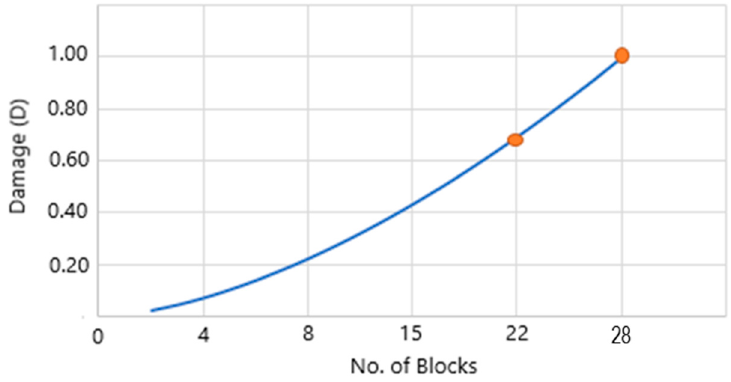
Figure 8. Damage